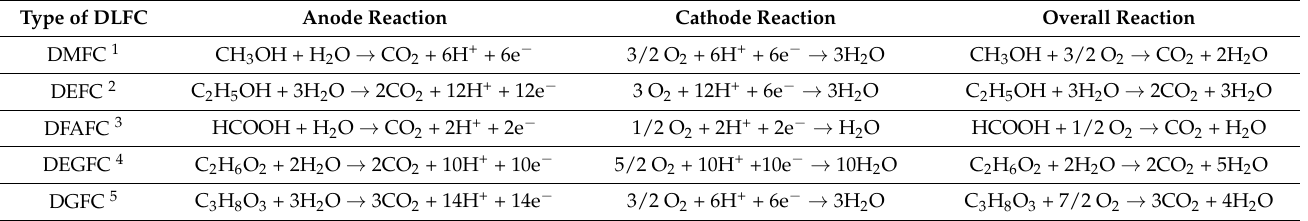
Table 1. Table listing the DLFCs that are most commonly studied and associated electrochemical reactions involving supported Pd catalysts. Reprinted with permission from